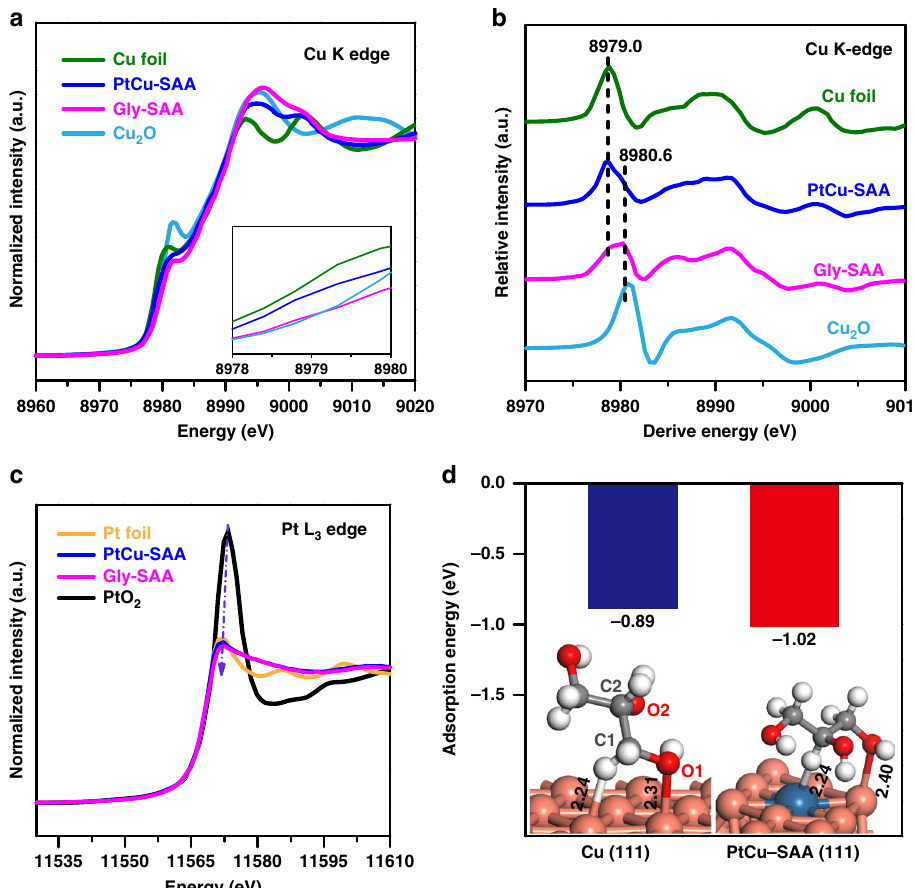
Fig. 7 Identi fi cation of catalytic active center. a In situ normalized XANES spectra and b corresponding fi rst derivative pro fi le at Cu K – edge of: Cu foil,